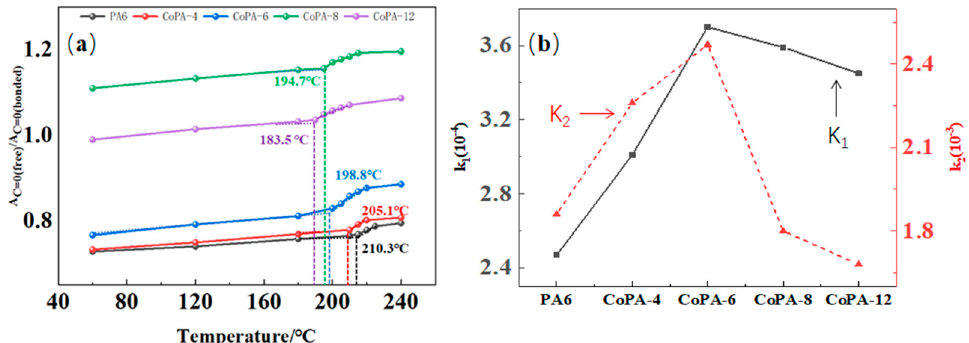
Figure 6. The temperature dependence of the fraction ratio of ordered hydrogen–bond and free